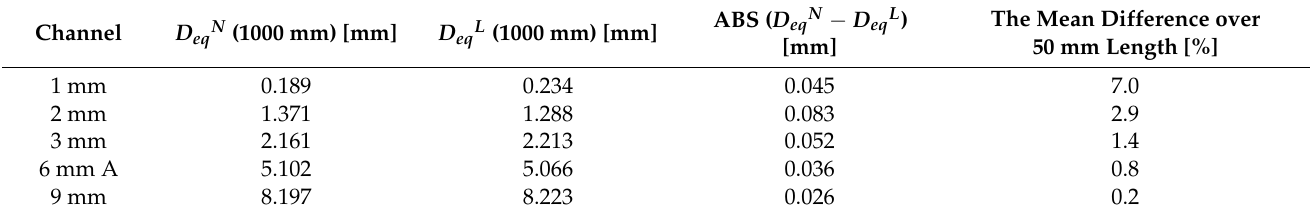
Table 3. Estimation of D eq . Comparison of normal ( N ) and large ( L) image stacks. Channel